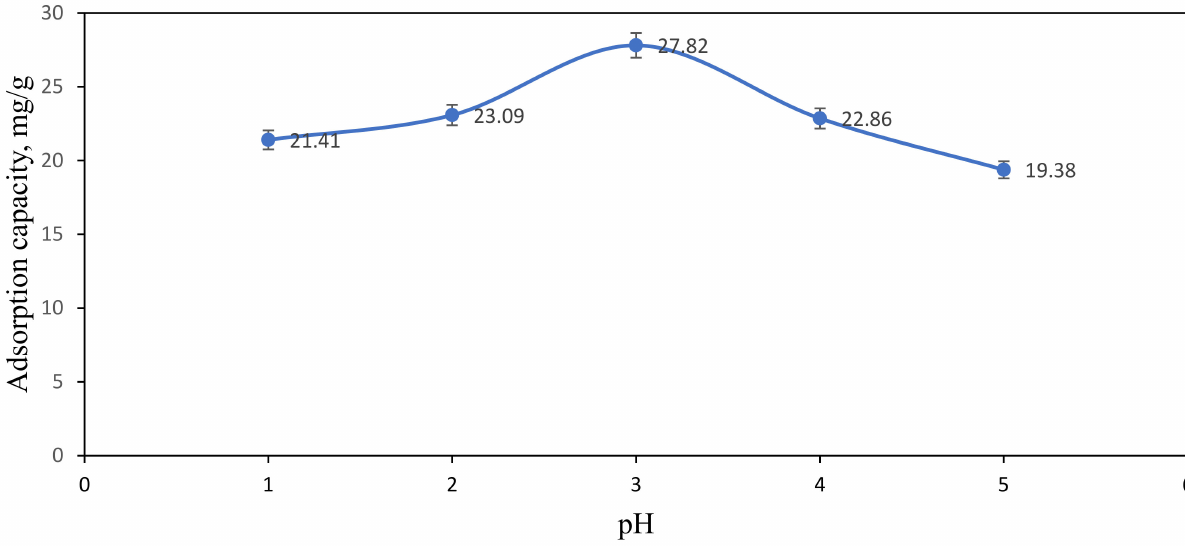
Figure 9. Effect of pH on adsorption capacity of Ni(II) ions. Condition: [Ni(II)] = 100 ppm, dosage of adsorbent = 50 mg, contact time = 60